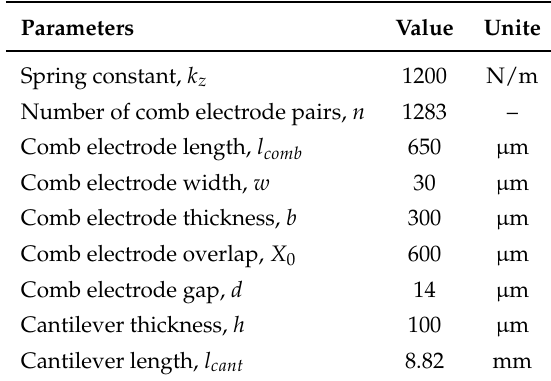
Table 1. The designed device